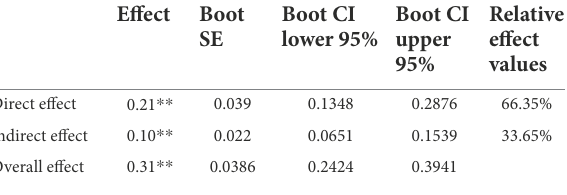
TABLE 2 The direct effect and indirect effect in the mediating model.